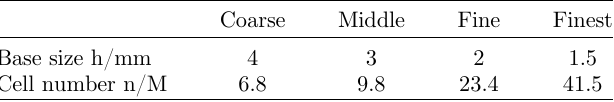
Table 2. Used mesh sizes and cell numbers for the investigation of convergence.